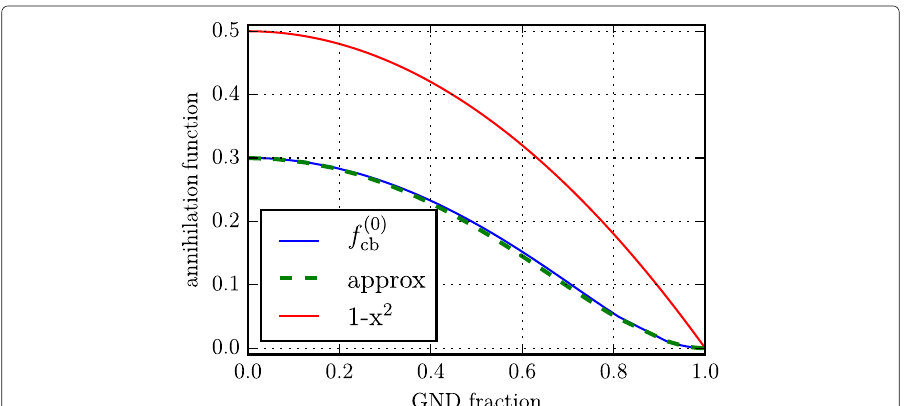
Fig. 9 Blue line: climb annihilation function of ρ as a function of the GND fraction. Green dashed-line: analytical fit (0.3 ( 1 − 1.5 x 2 + 0.5 x 6 ) ) to the annihilation rate. Red line: parabolic rate